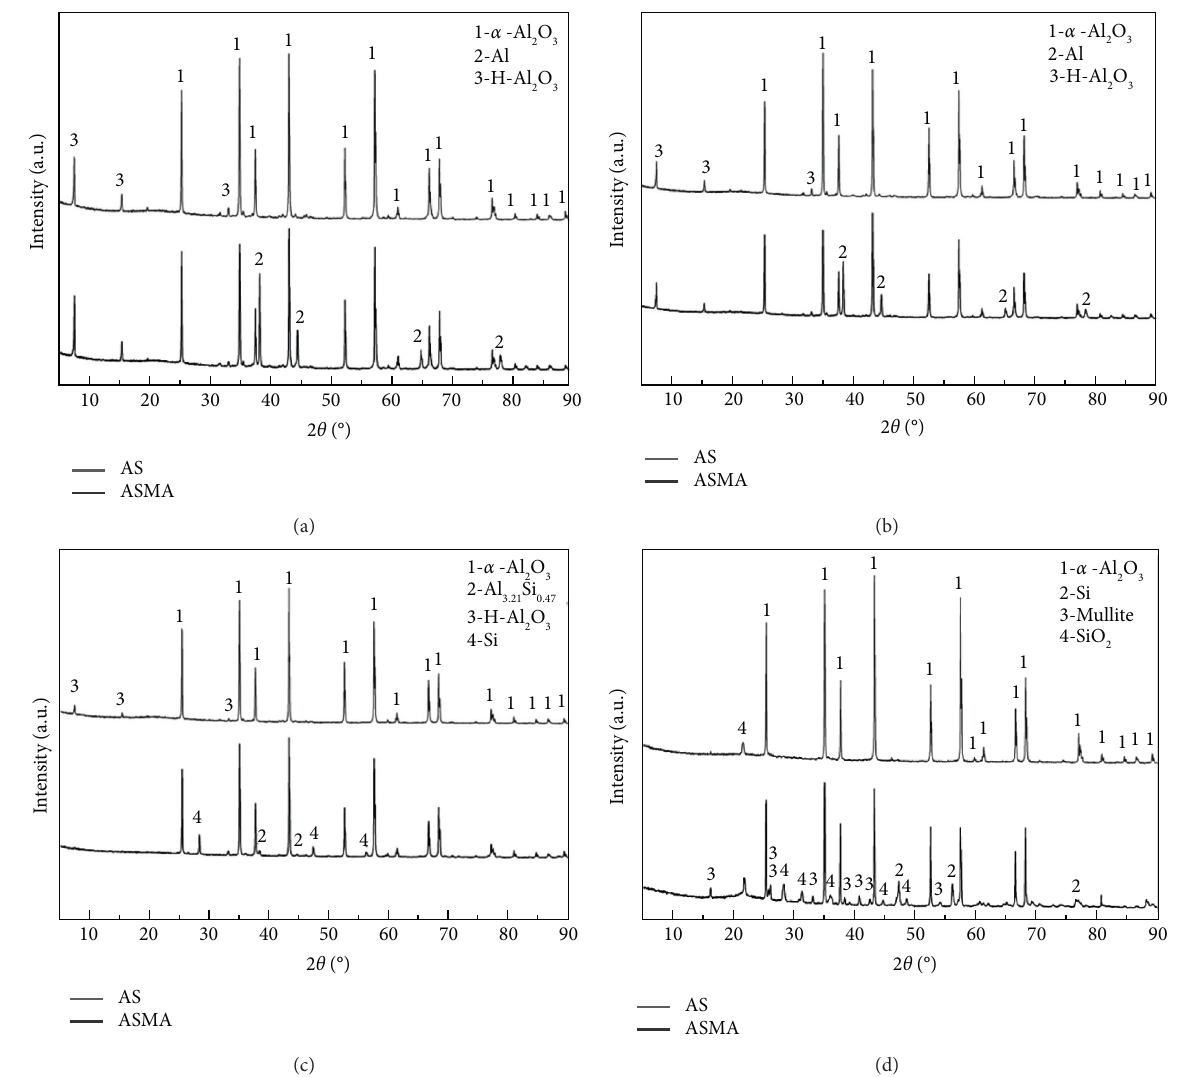
Figure 4: Local image information for the first derivative